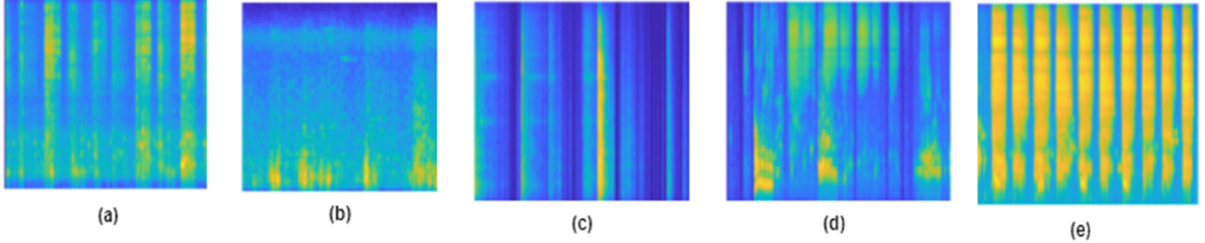
Figure 3. Samples of Mel Spectrogram images generated from the audio files in each class ( a ) Positive Asymptotic; ( b ) Positive mild; ( c ) Positive Moderate; ( d ) Recovered full; ( e )